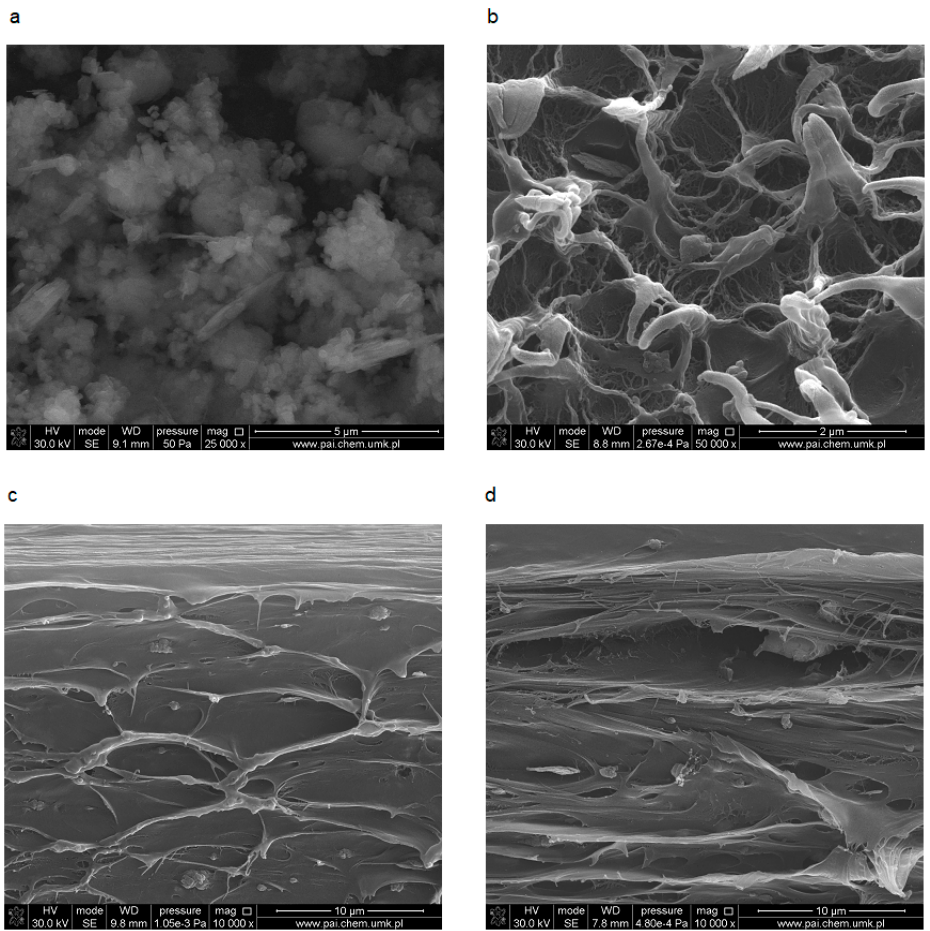
Figure 2. SEM images of Sillikolloid P87 ( a ), MDPE + 5% Sillikolloid P87 non-oriented (NO) ( b ), MDPE + 5% Sillikolloid P87 oriented (O) ( c ), MDPE + 10% Sillikolloid P87 oriented (O) ( d ); c–d, cross-sections.